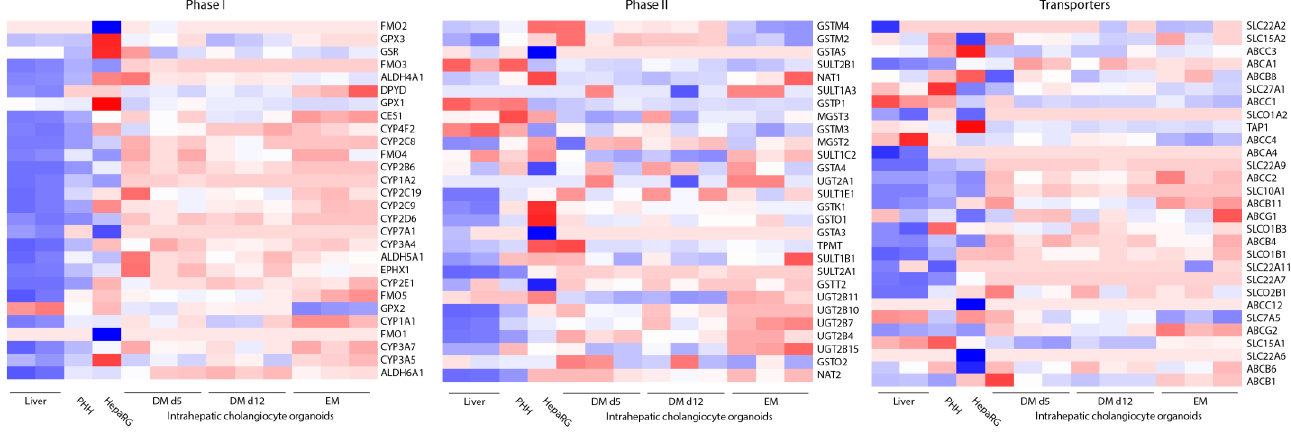
Table 1. Comparison of enzyme-specific metabolite formation rates in HL-ICOs, PHHs and HepaRG. HL-ICOs